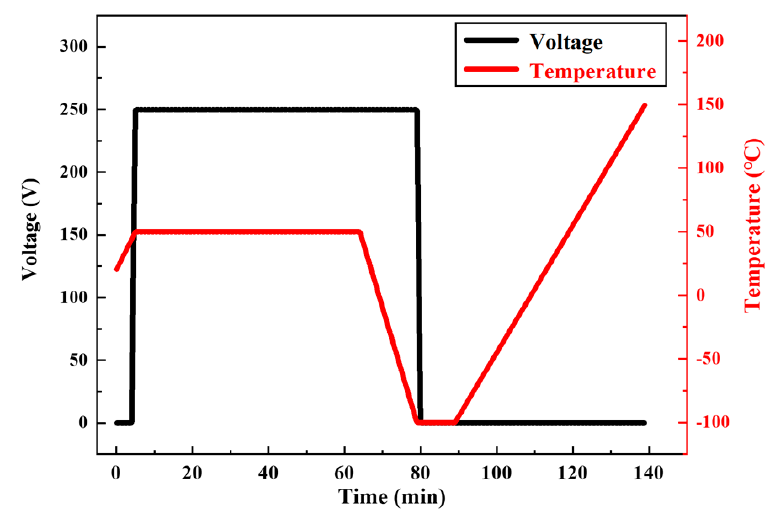
Figure 3. Applied temperature and voltage trend curve over time during the thermally stimulated depolarization current (TSDC) test.